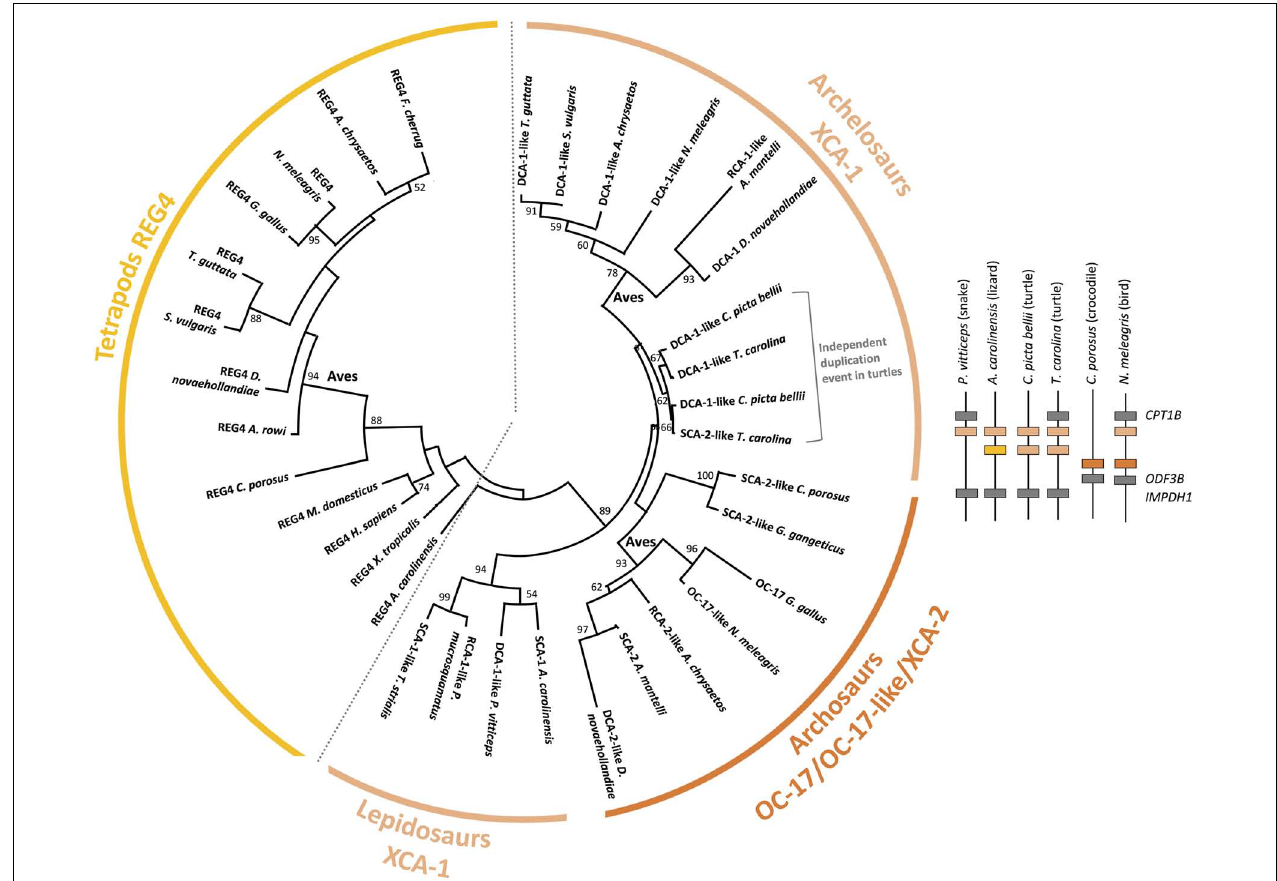
FIGURE 10 | Phylogenetic reconstruction of OC-17 and its orthologs and paralogs in vertebrates. Phylogeny was performed using the maximum likelihood method with 100 repetitions (MEGAX v10.1.8; https://www.megasoftware.net/) using ClustalW multiple alignment and Gblocks (www.phylogeny.fr), and the WAG + G model of protein evolution. Bootstrap values from maximum likelihood are indicated at each node when value is > 50. Synteny of OC-17-like/XCA-2 and XCA-1 genes is represented for five reptilian species ( Pogona vitticeps , Anolis carolinensis , Chrysemys picta bellii , Terrapene carolina triunguis, and Crocodylus porosus ) and one bird ( Numida meleagris